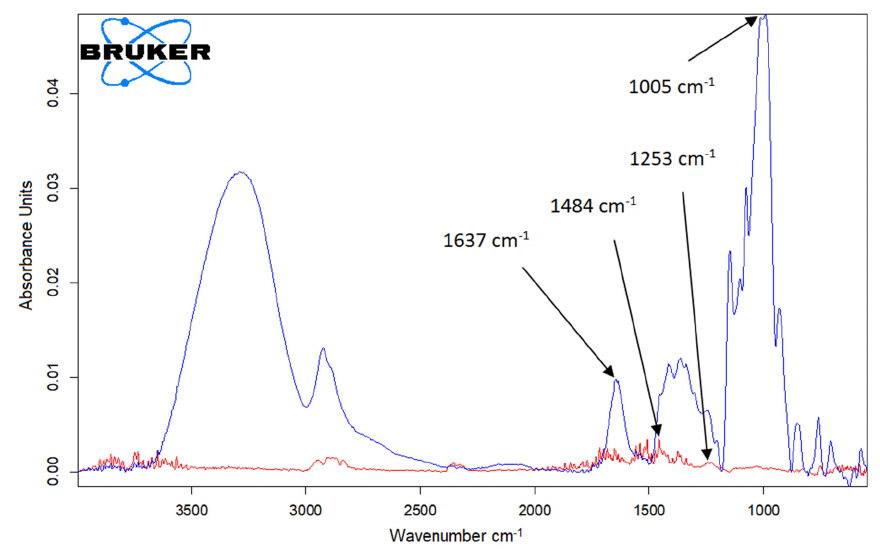
Figure 1. FTIR spectra for CNF-CoPc/SPE (red line) and CNF-CoPc-Lac/SPE (blue